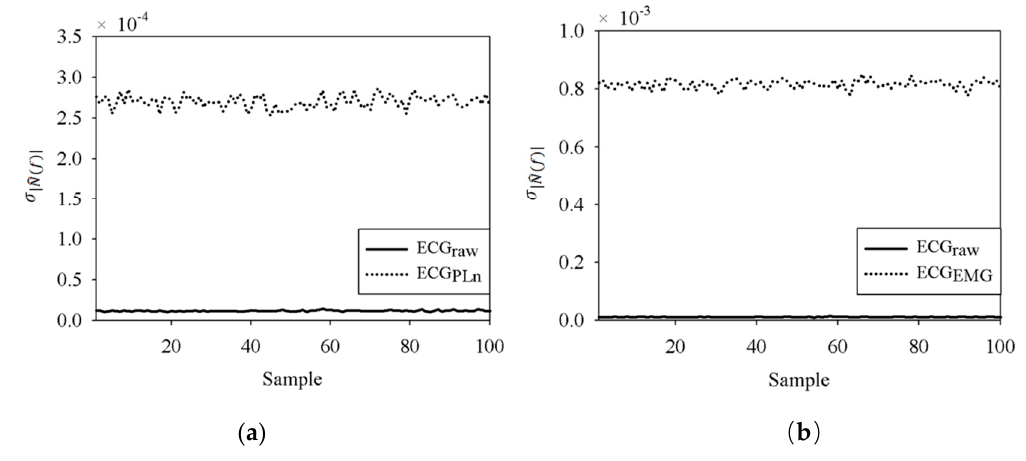
Figure 3. Differences of σ | ˆ Figure 3. Differences of 𝜎 |(cid:3015)(cid:3553)((cid:3033))| ( a ) ECG (cid:2928)(cid:2911)(cid:2933) vs ECG (cid:2900)(cid:2896)(cid:2924) ( b ) ECG (cid:2928)(cid:2911)(cid:2933) vs ECG (cid:2889)(cid:2897)(cid:2891) ( a ) ECG raw vs ECG PLn ( b ) ECG raw vs ECG EMG . N ( f ) |